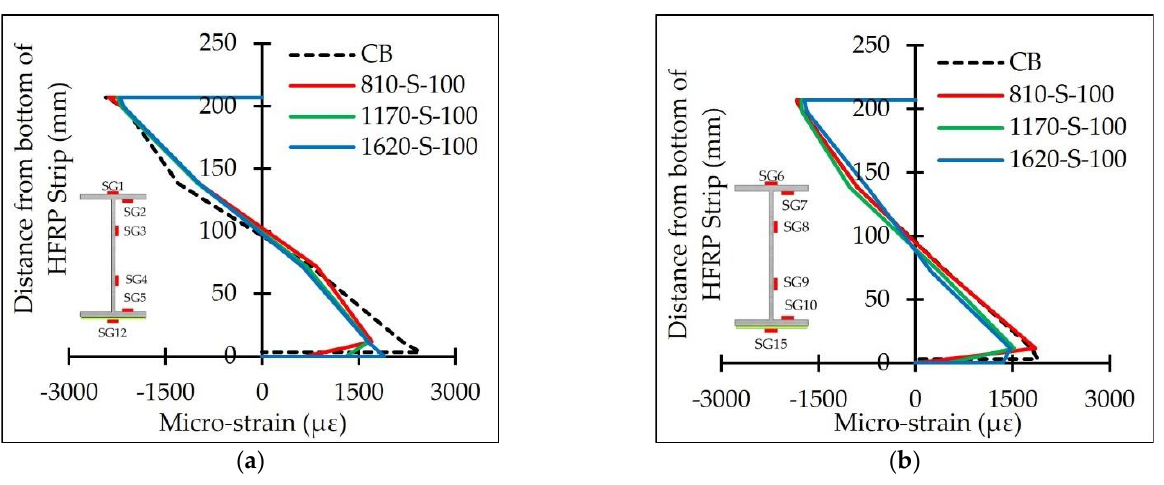
Figure 25. Strain profiles of CB, 810-S-100, 1170-S-100 and 1620-S-100 at 310 kN at: ( a ) mid-segments; ( b ) edge-segments.